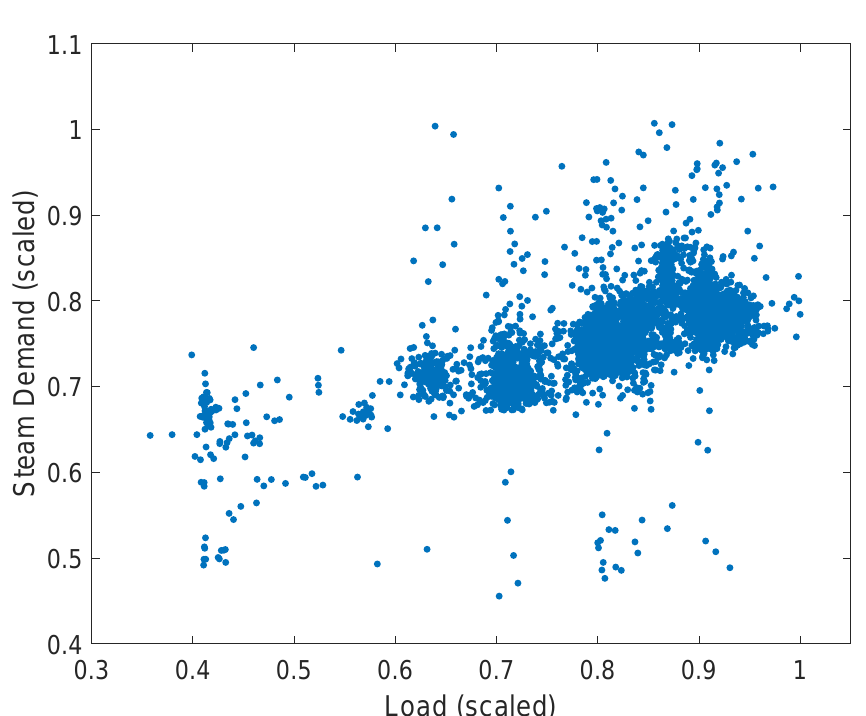
Figure 2. The uncertain steam demand in a production plant of INEOS in Köln